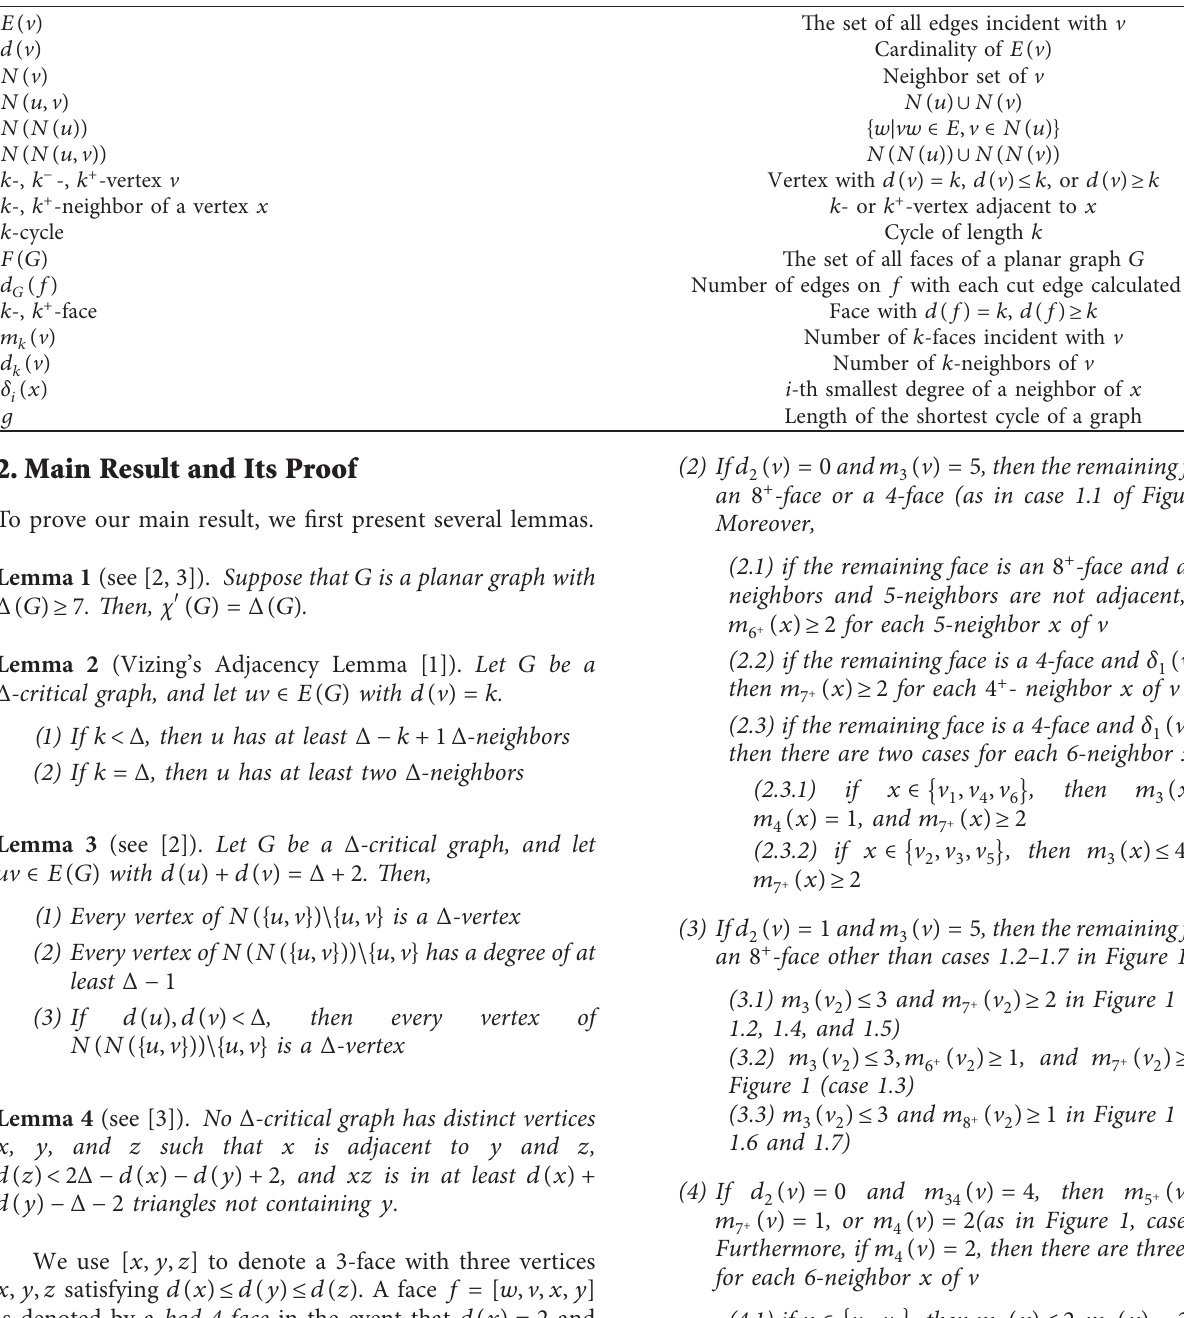
Table 1: Symbols of